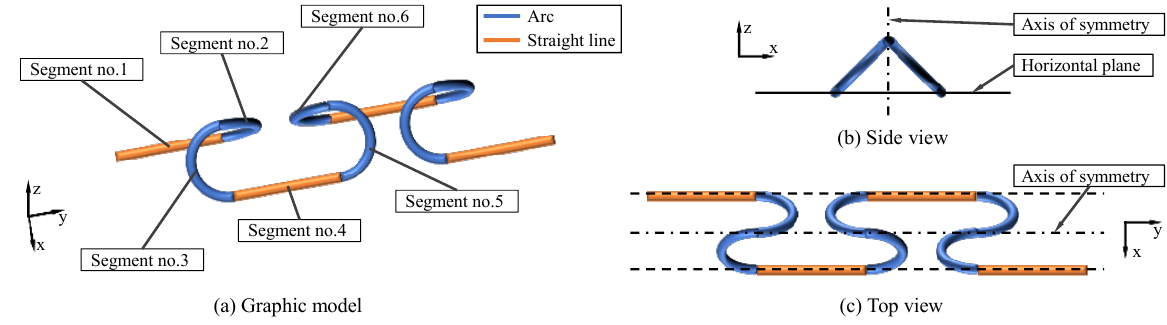
Figure 3. Target configuration curve of crawler gait. The curve is composed of two straight lines and four arcs. When the snake robot moves with crawler gait, the side view of the configuration curve is an isosceles triangle.